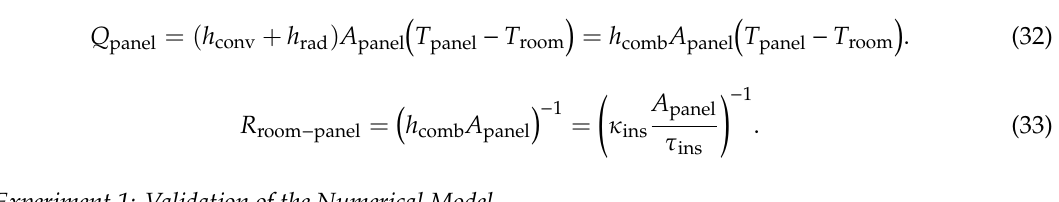
Figure 6. Simulation results for the TERP in heating mode: ( a ) T surf = 45 °C and ( b ) T surf = 60 °C.